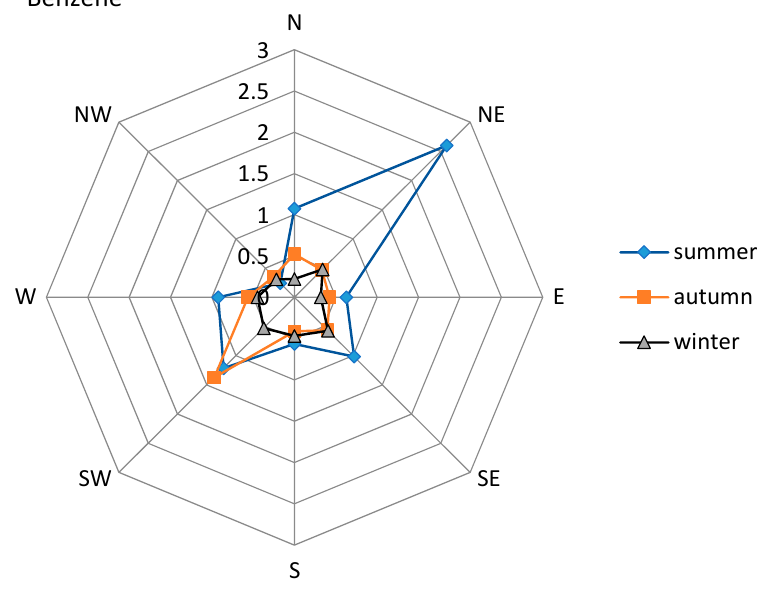
Figure 4. Benzene concentration and wind direction diagrams (µg m − 3 ).